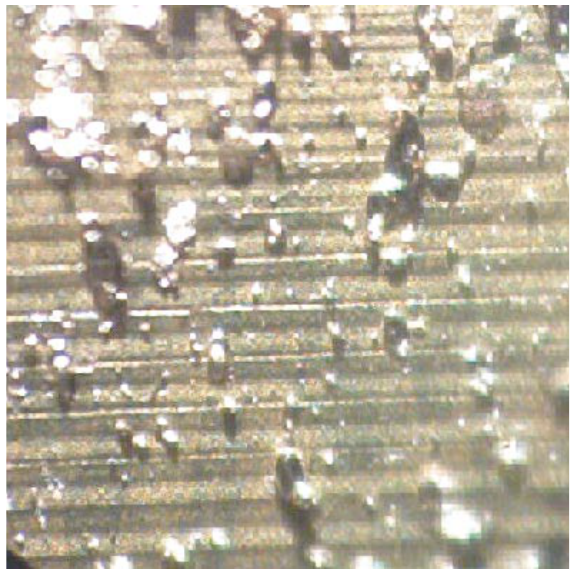
FIG. 25. (Color) Type 2 film parameters with an approximate glass response